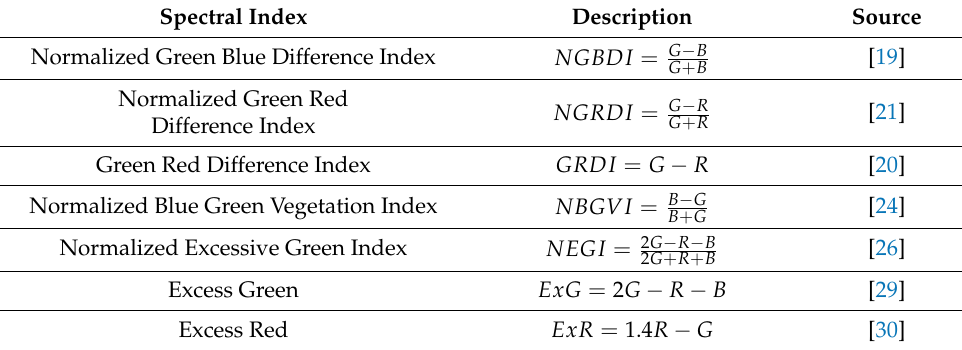
Table 3. Image spectral index for extracting target